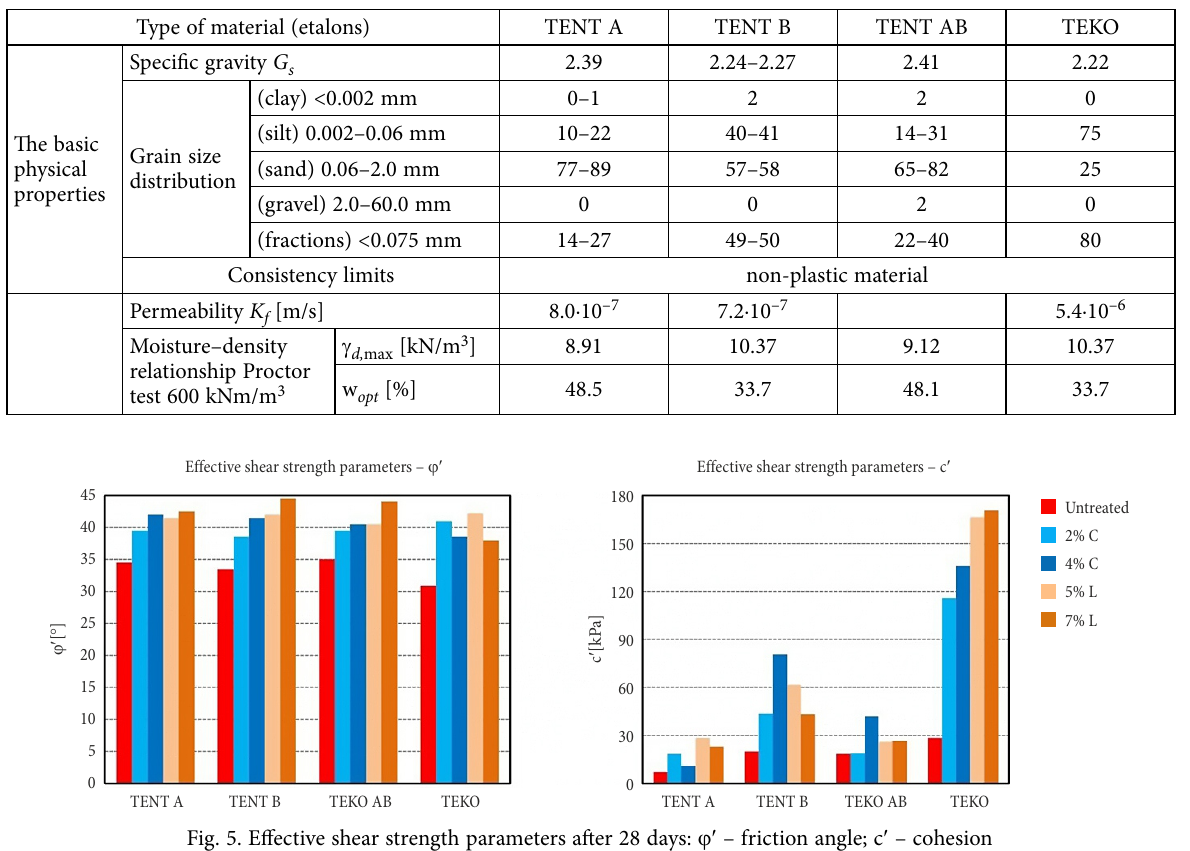
Fig. 5. Effective shear strength parameters after 28 days: φ ′ – friction angle; c ′ – cohesion